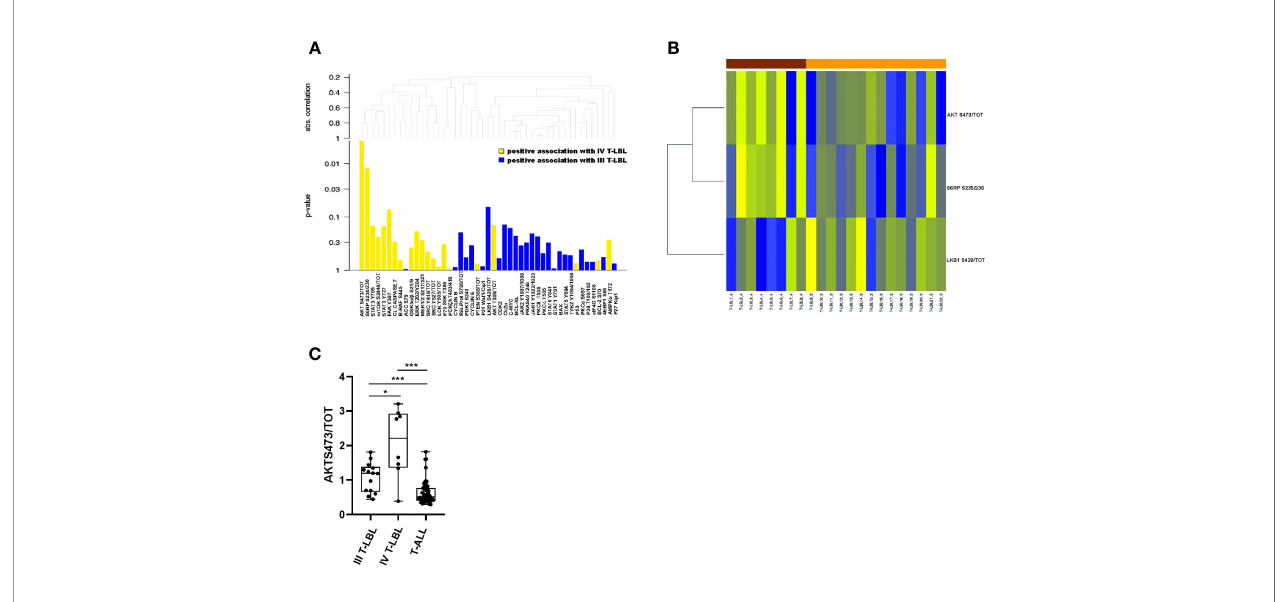
FIGURE 3 | Differentially expressed proteins between stage IV and stage III T-LBL samples. (A) Hierarchical clustering graph (HCG) of all proteins, and a set of proteins being positively associated with stage IV or stage III T-LBL, with different intensities (height of columns is equal to p-values of single tests). Positive association with stage IV T-LBL (or T-ALL) refers to hyperactivated proteins in stage IV T-LBL (or in T-ALL). (B) Heatmap of the three signi fi cantly differentially expressed proteins between stage IV and stage III T-LBL samples (based on non-corrected p-values from single tests). (C) AKT S473/tot phosphorylation levels measured by RPPA analysis were signi fi cantly upregulated in stage IV T-LBL samples (n=8) compared to both T-ALL (n=57) and stage III T-LBL (n=14).*p < 0.05; ***p <